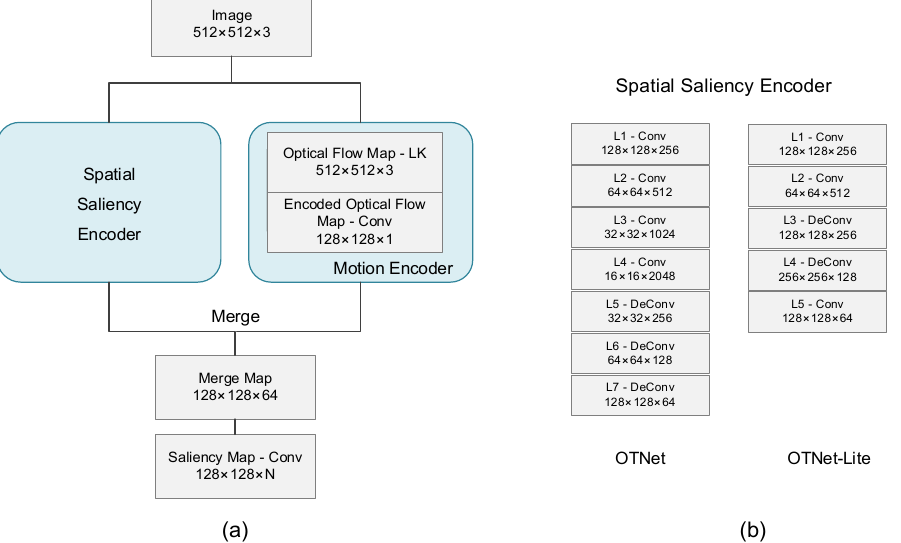
Figure 3. The detailed structures of the models. ( a ) The overall structure of the model. ( b ) The dif ‐ ference between OTNet and OTNet ‐